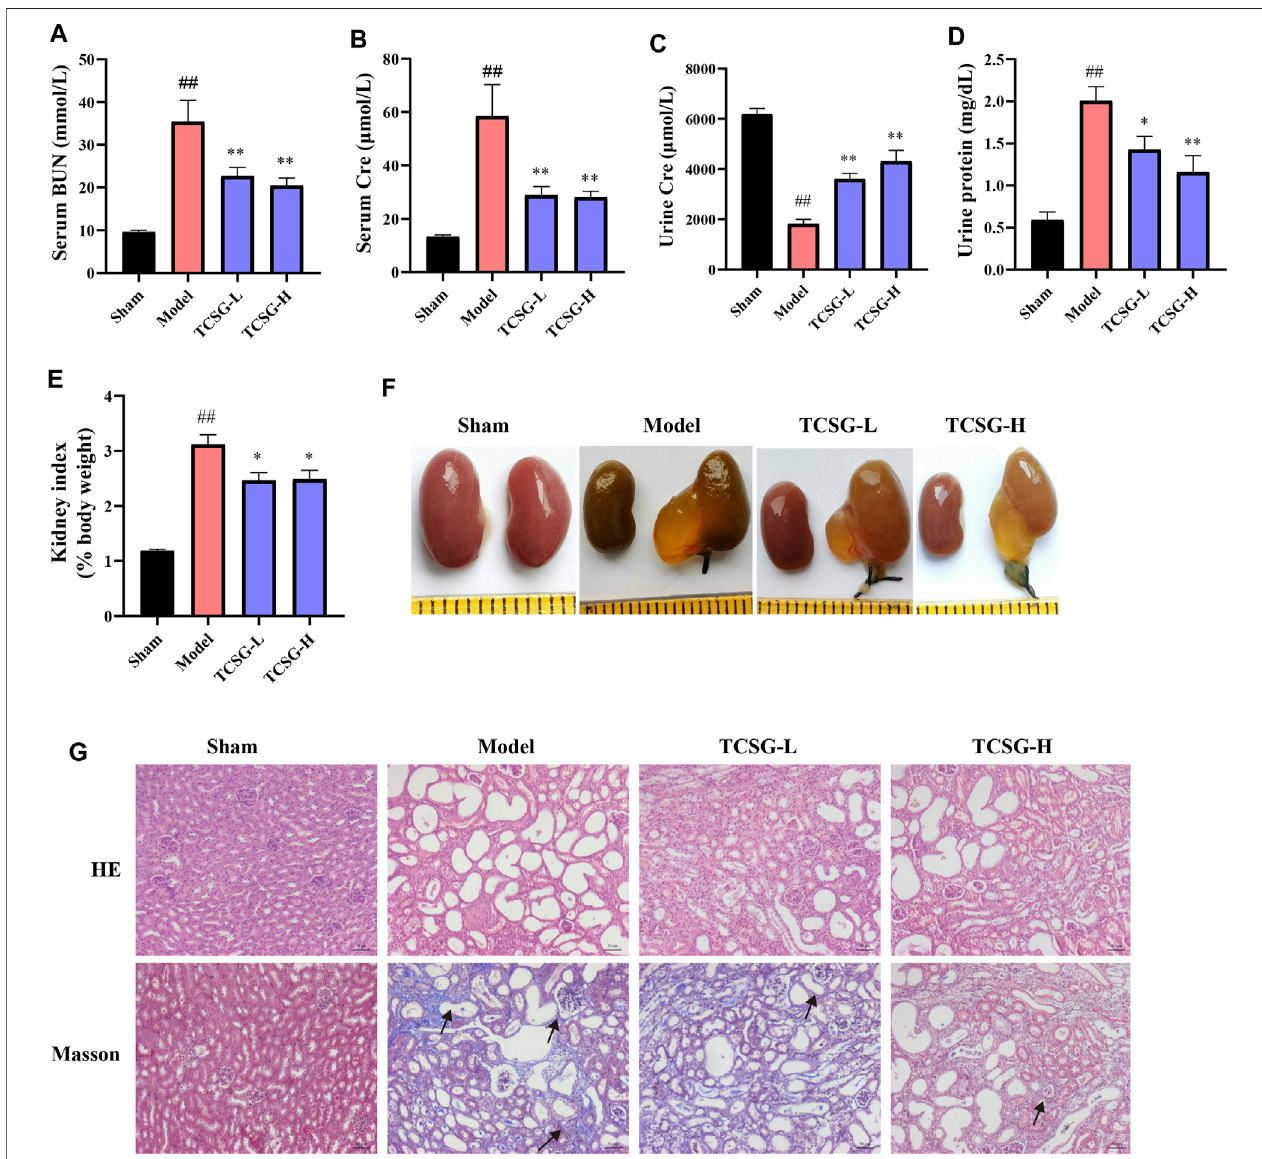
FIGURE 2 | TCSG from Baishouwu relieved kidney injury in BDL&UUO mice. (A,B) The effects of TCSG on serum biochemical measurements of kidney injury. (C,D) TheeffectsofTCSGonurinebiochemicalmeasurementsofkidneyinjury. (E) TheeffectsofTCSGonthekidneyindex. (F) TheeffectsofTCSGonthemorphologic changes of the kidney. (G) The effects of TCSG on kidney pathological changes detected by HE staining and kidney collagen accumulation determined by Masson staining (scale bar 50 μ m). Data are shown as means ± SEM ( n (cid:1) 10 – 12), ## p < 0.01, signi fi cantly different from sham group; * p < 0.05, ** p < 0.01, signi fi cantly different from model